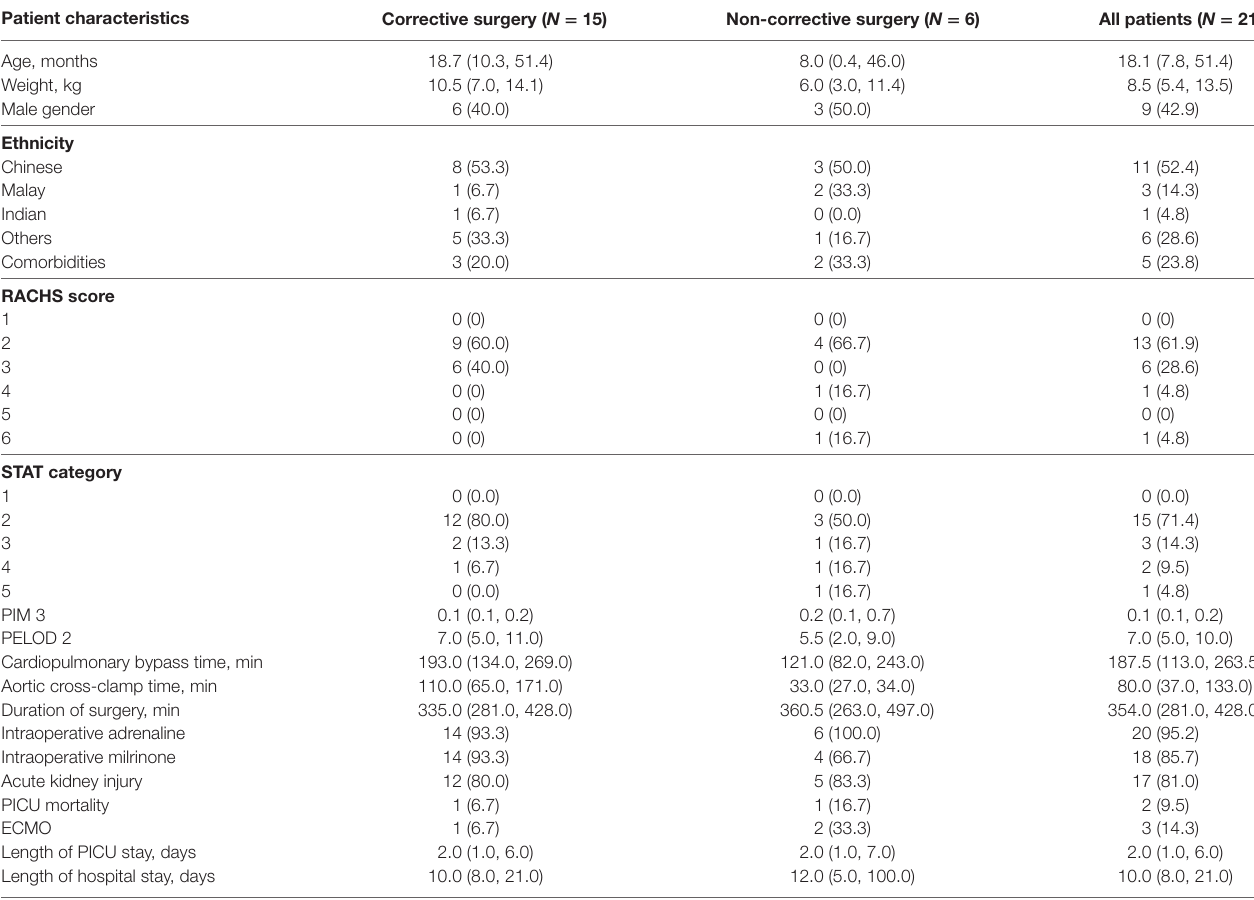
TaBle 1 | Summary of patient characteristics ( N =